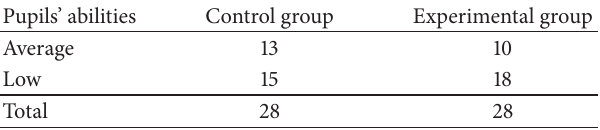
Table 1: Pupils’ abilities in control and experimental